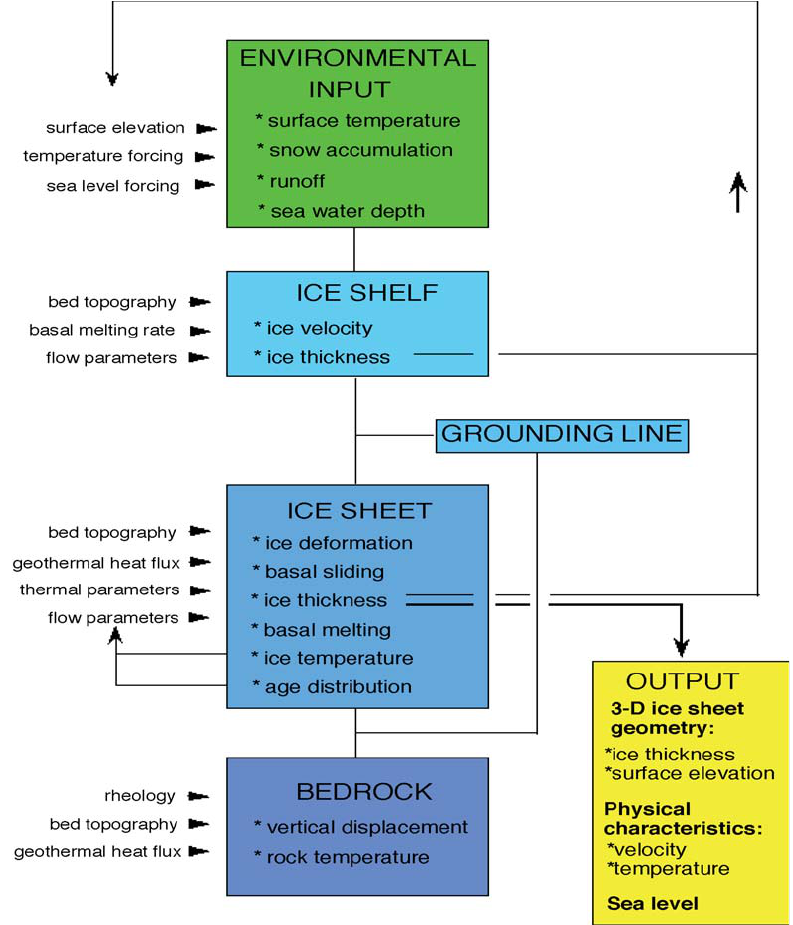
Fig. 6. Structure of the three-dimensional ice sheet model AGISM. The inputs are given at the left-hand side. Prescribed environmental variables drive the model, which has ice shelves, grounded ice and bed adjustment as major components. For the Antarctic component, the position of the grounding line follows from a flotation criterion and a specific treatment of the force balance. Ice thickness feeds back on surface elevation, an important parameter for the calculation of the mass balance. The main model outputs the time-dependent ice sheet geometry and the coupled temperature and velocity fields.